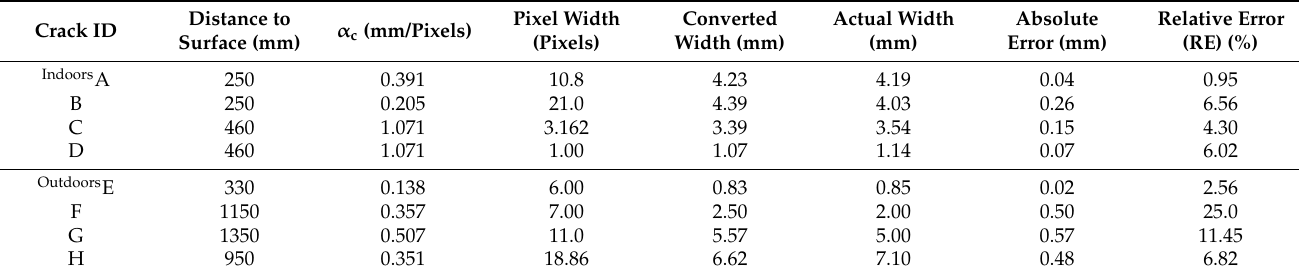
Table 3. Measured maximum crack